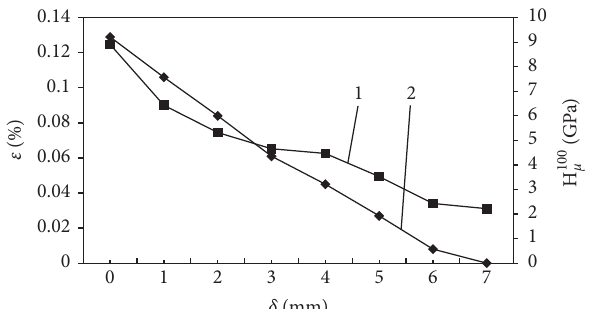
Figure 9: Distribution of microhardness (1) along the depth of the hardened sample δ and the relative microdeformation of the crystal lattice (2) after VCH with a processing time of 28min and a weight of the hardening tool of